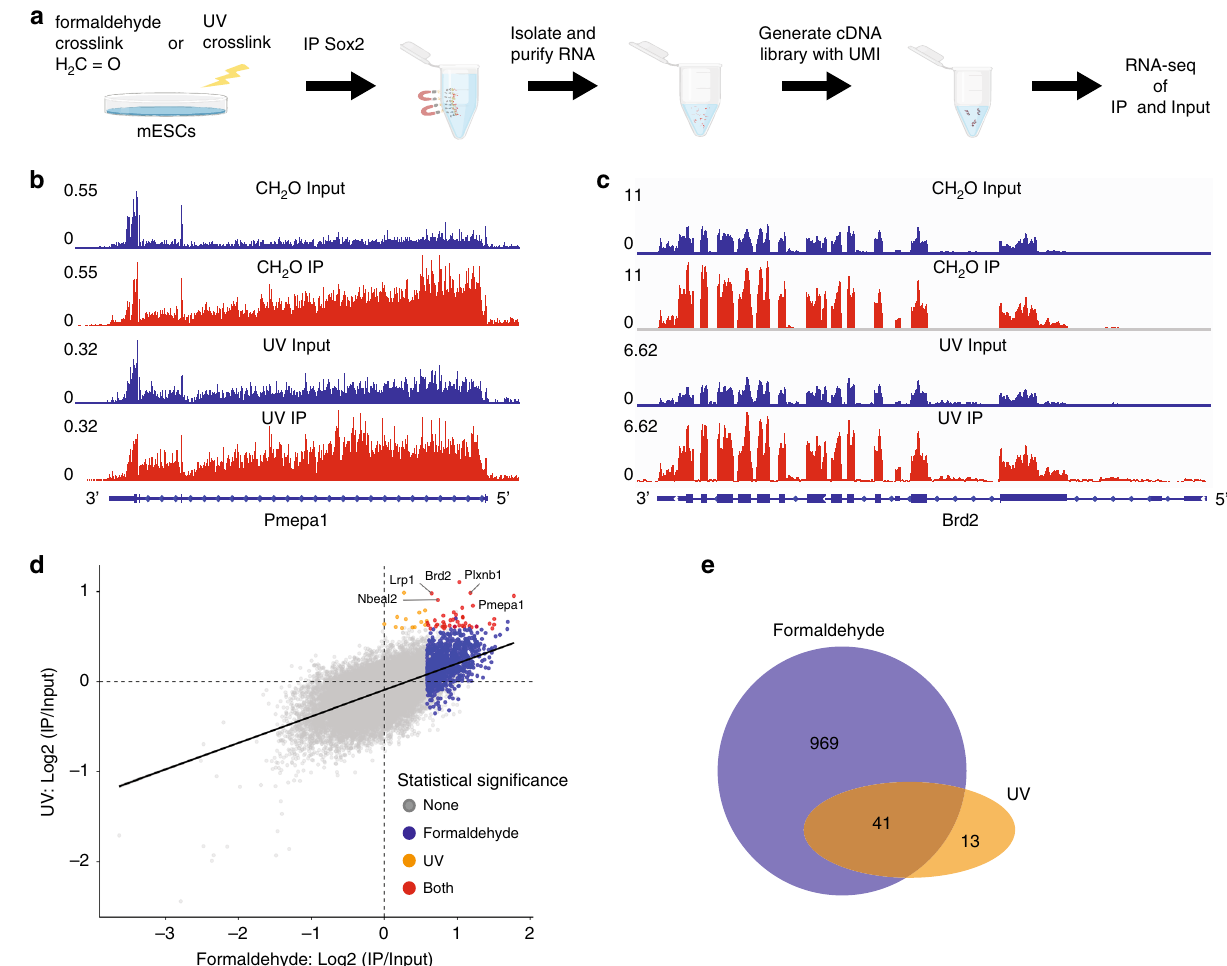
Fig. 7 Sox2 interacts with RNA in mESC. a Schematic of fRIP and UV-RIP-Seq experimental fl ow. b , c Examples of enriched genes (Pmepa1 and Brd2) identi fi ed by both formaldehyde ( “ CH 2 O ” ) and UV-based RIP-seq. Each panel describes normalized coverage of sequencing reads (RPM: reads per million reads). d Correlation of enrichment between fRIP and UV-RIP. A dot represents a gene and each axis describes the fold change of IP relative to input in log scale. A color indicates statistical signi fi cance of enrichment (FDR-adjusted p -value<0.05): blue signi fi cant only by formaldehyde, orange: signi fi cant only by UV, red: signi fi cant by both formaldehyde and UV. e Overlap of genes enriched in both fRIP and UV-RIP. Data for both fRIP ( n = 4) and UV-RIP ( n = 4) are obtained from eight total distinct cell culture